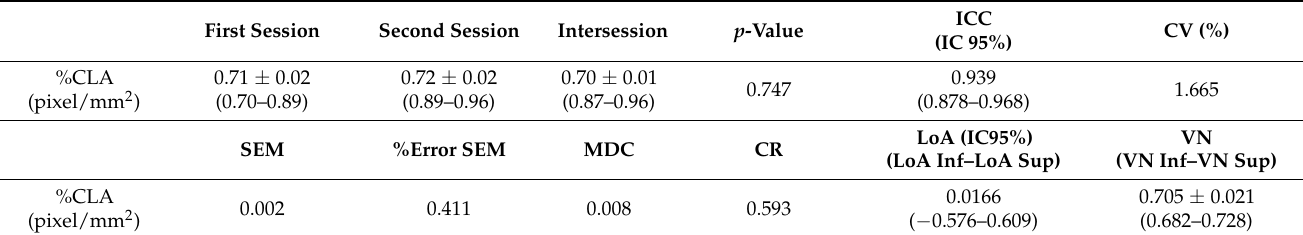
Table 4. Reliability of the percentage of the center of pressure locus area in the intersession without